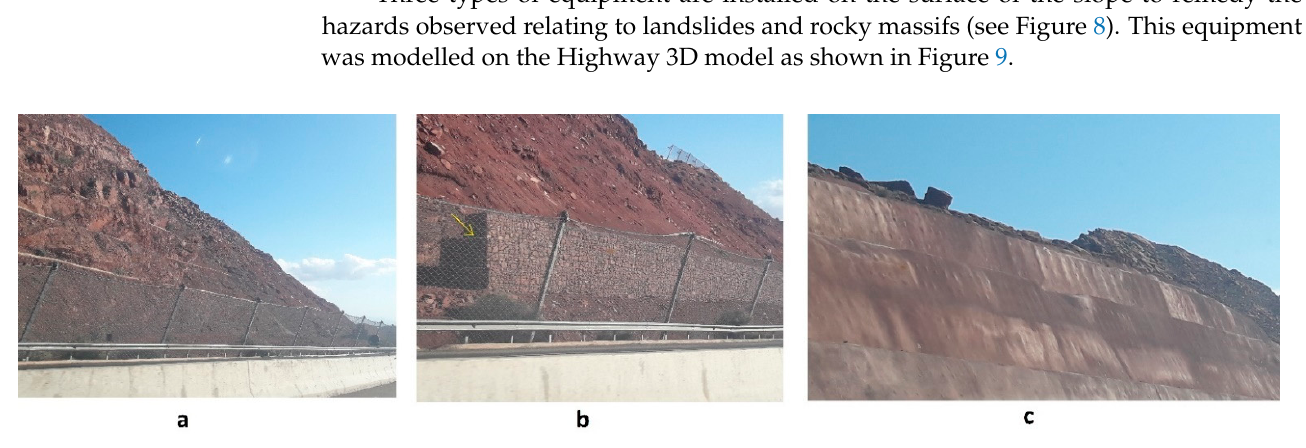
Figure 8. Security Equipment installed on the slope: ( a ) Dynamic barrier, ( b ) Gabion wall, ( c ) Shotcrete berms.